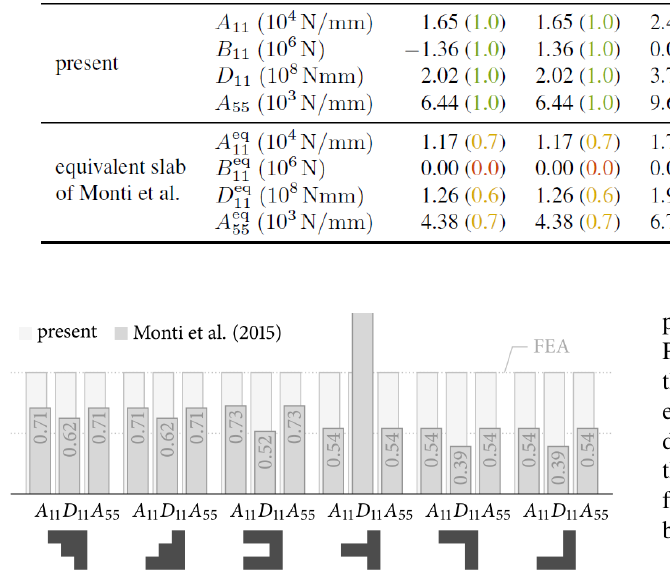
Figure 11. Slab extension, bending, and shear stiffnesses A 11 (Nmm − 1 ), D 11 (Nmm), and A 55 (Nmm − 1 ) of the present model and the equivalent isotropic slab approach by Monti et al. (2016) normalized to the finite-element analysis (FEA) reference stiffness. The bending–extension coupling stiffness B 11 (N) is not shown be- cause it is always zero in the model of Monti et al. (2016) and agrees exactly between reference and present model; see Table